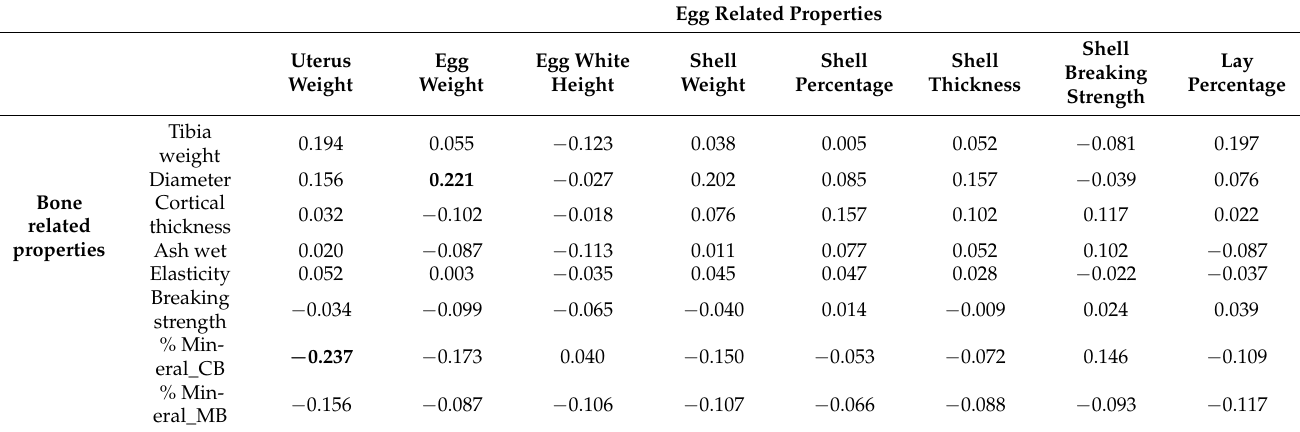
Table 5. Pearson’s correlation analysis between tibiae bone properties and egg